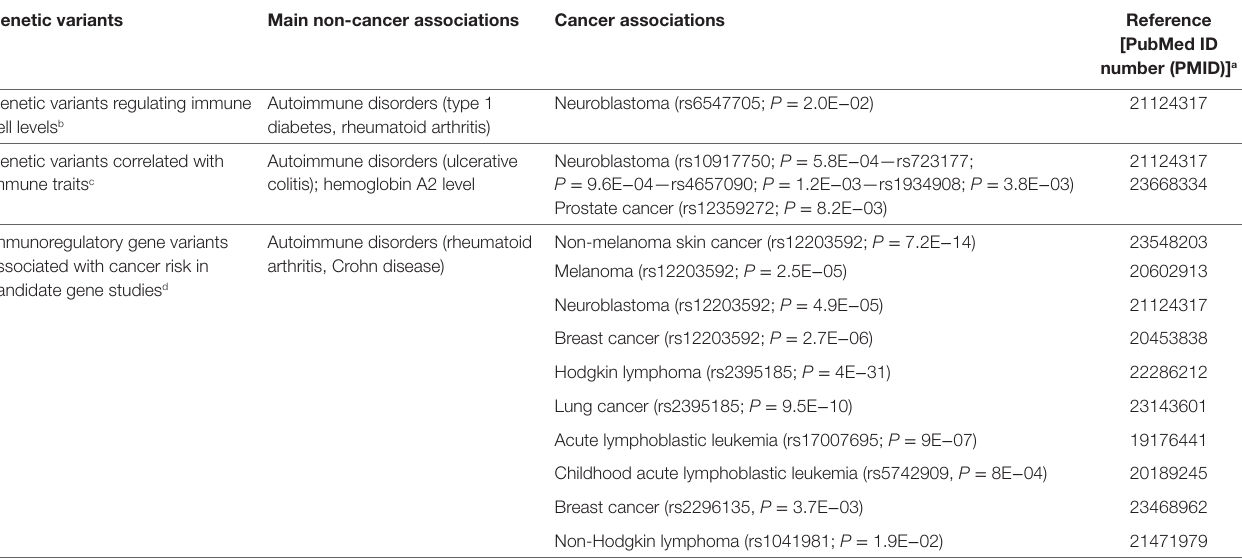
TAbLe 1 | immune regulatory gene polymorphisms and cancer susceptibility in GwAS and GRASP